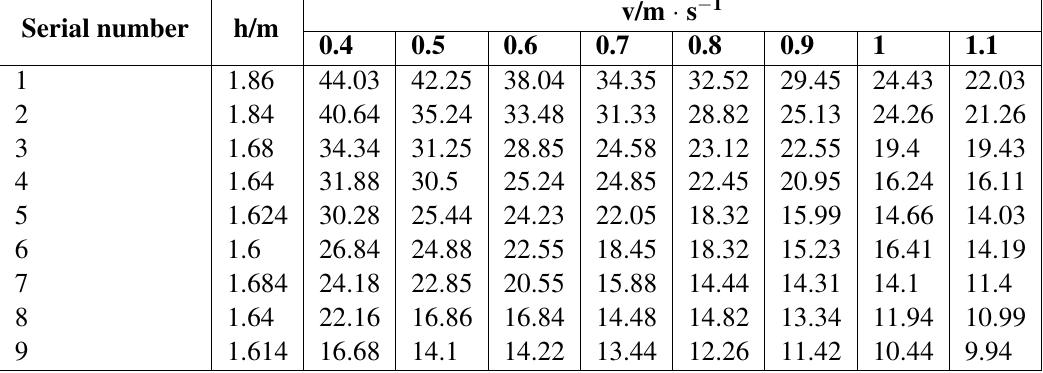
Table 1 The amplitude of limb movement when subjects of different heights walk at different